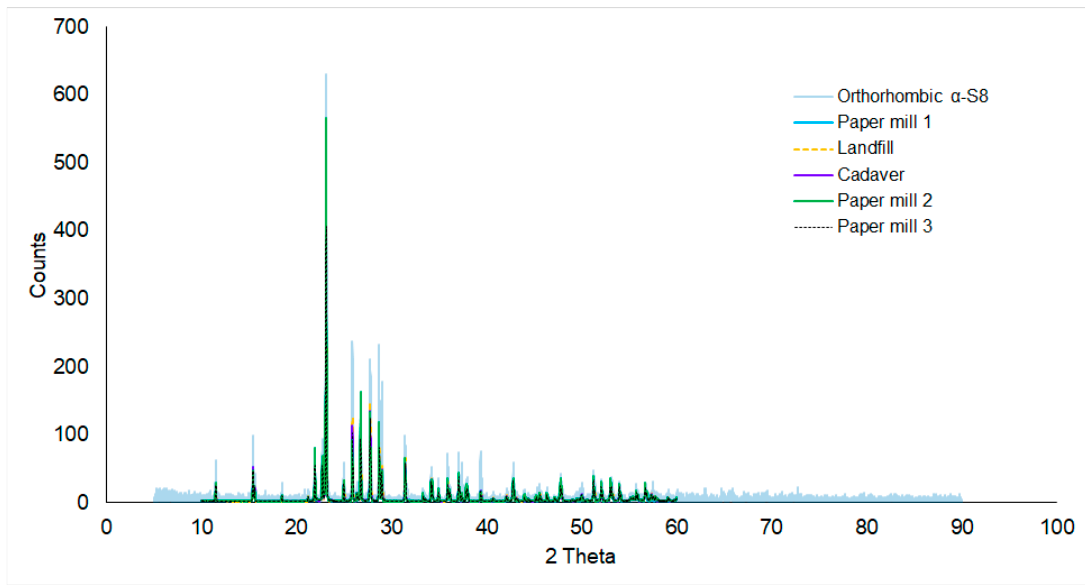
Figure A3. Di ff raction patterns for the five sulfur samples from the di ff erent industrial BD facilities. Figure A2. Diffraction patterns for the five sulfur samples from the different industrial BD facilities. All five samples show an identical di ff raction pattern matching with the pattern for orthorhombic All five samples show an identical diffraction pattern matching with the pattern for orthorhombic α - α -S S 8 [40]. 8